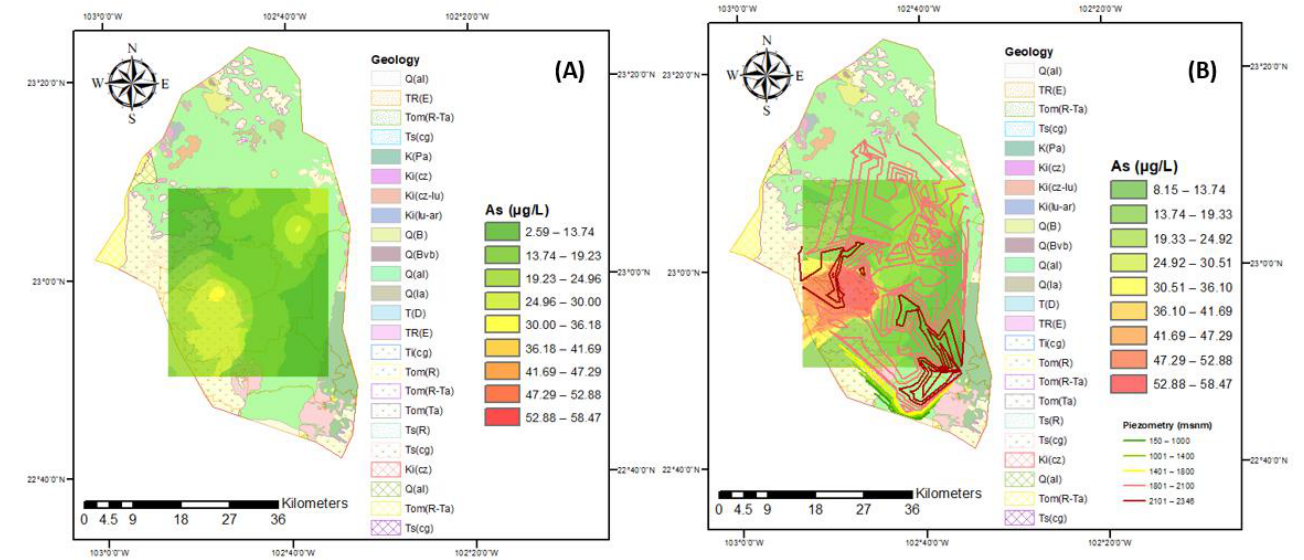
Figure 5. Corresponding arsenic concentration in the years ( A ) 2005 and ( B ) 2015.